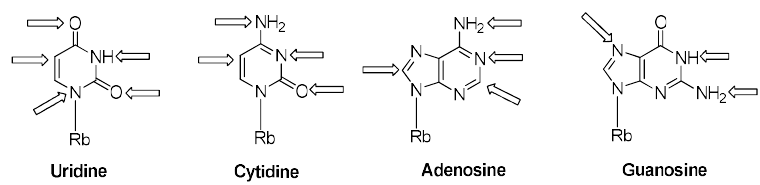
Figure 1. Modified positions distributed in naturally existing RNA nucleobases; Rb: ribose.